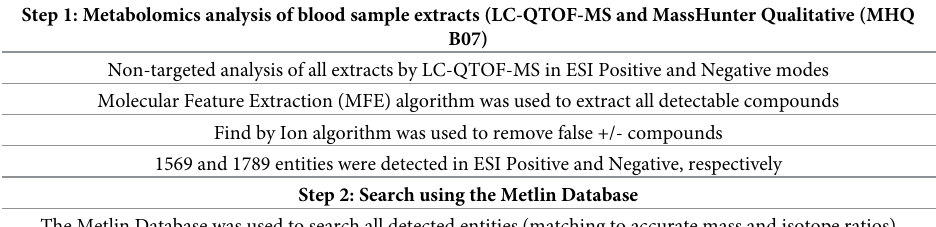
Table 2. The metabolomics workflow applied to blood samples collected from 42 cancer